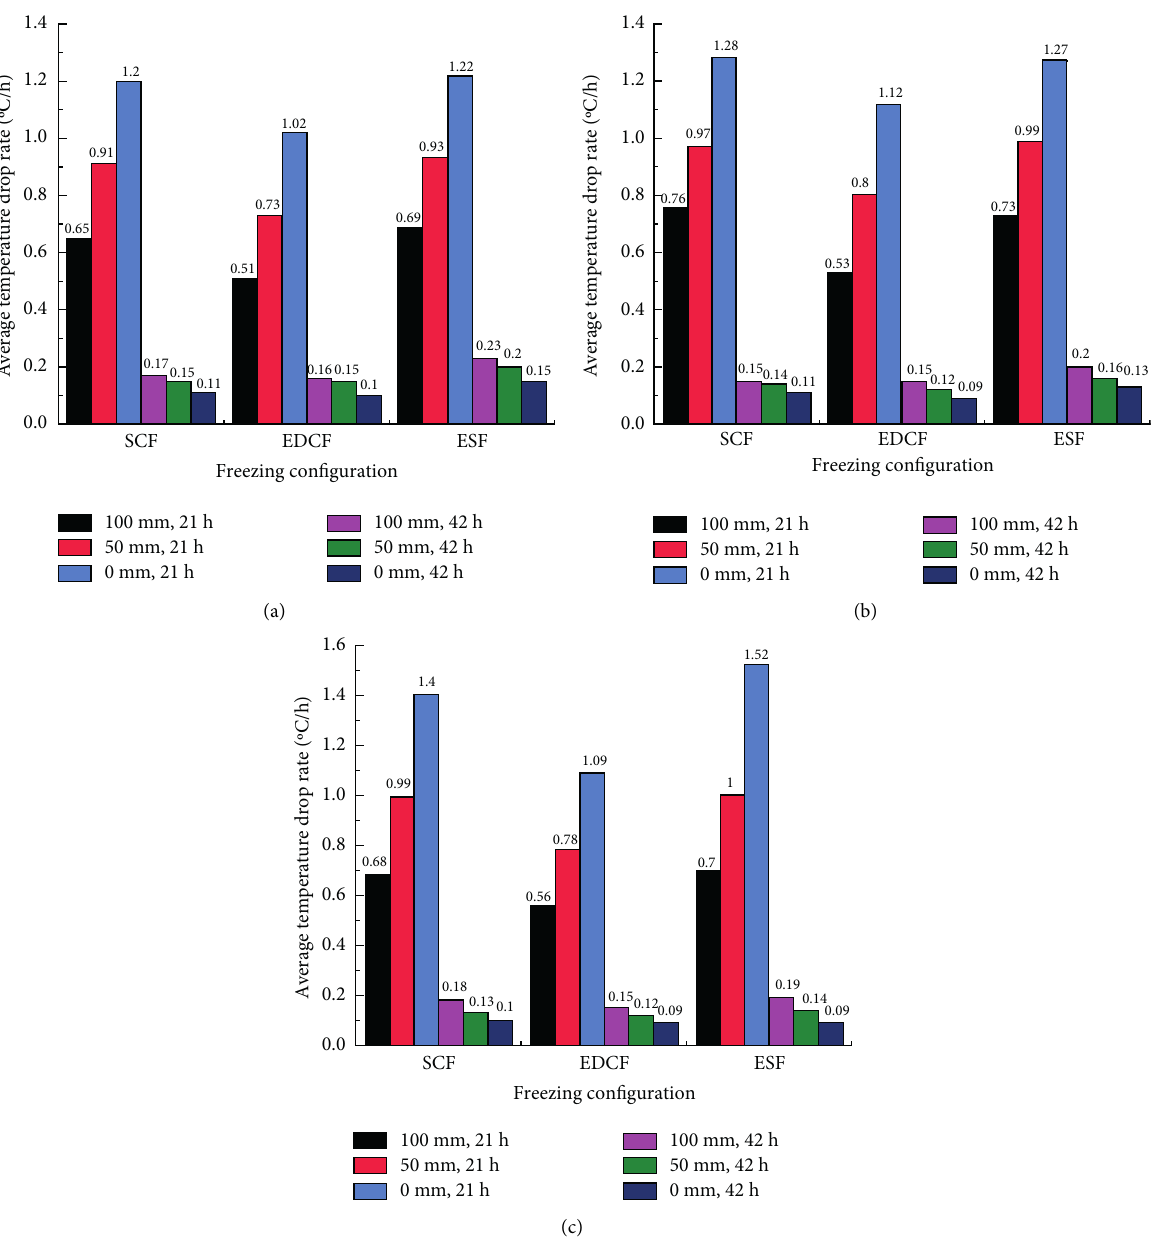
Figure 10: Average temperature drop rate of SCF, EDCF, and ESF: (a) 90 ° monitoring points; (b) 45 ° monitoring points; (c) 0 ° monitoring